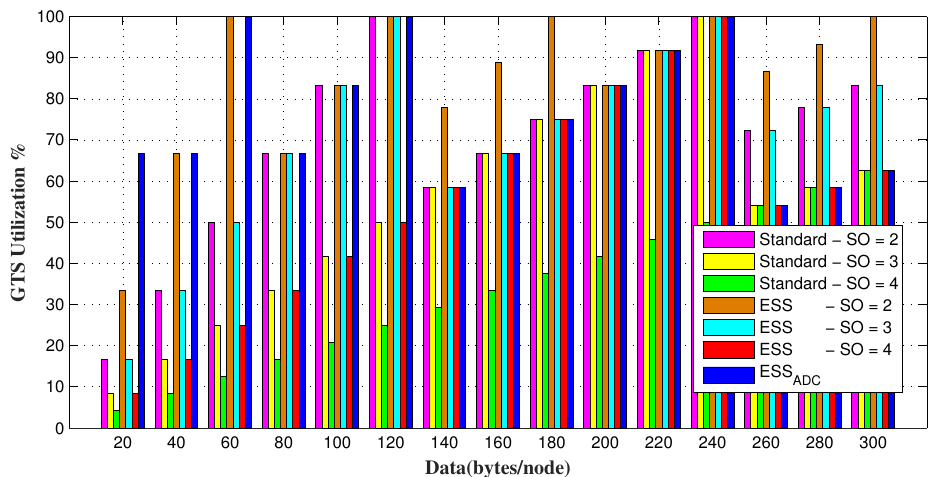
Figure 9. GTS utilization of the network for varying range of fixed data requesting nodes.